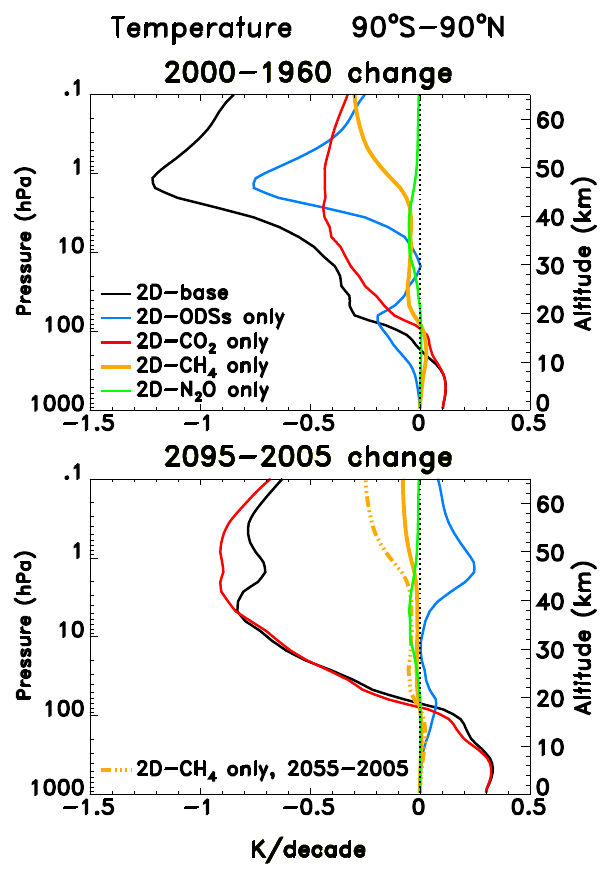
Fig. 11. (Top) Vertical profiles of the annual and global averaged temperature change (K decade − 1 ) for 2000–1960 (top) and 2095–2005 (bottom) from 2-D model simulations as follows: base (black solid); ODSs only (blue solid); CO 2 only (red solid); CH 4 only (orange solid); and N 2 O only (green solid). In the bottom panel, the change due to CH is shown for 2095–2005 (orange solid) and 2055–2005 (orange dashed-dotted).